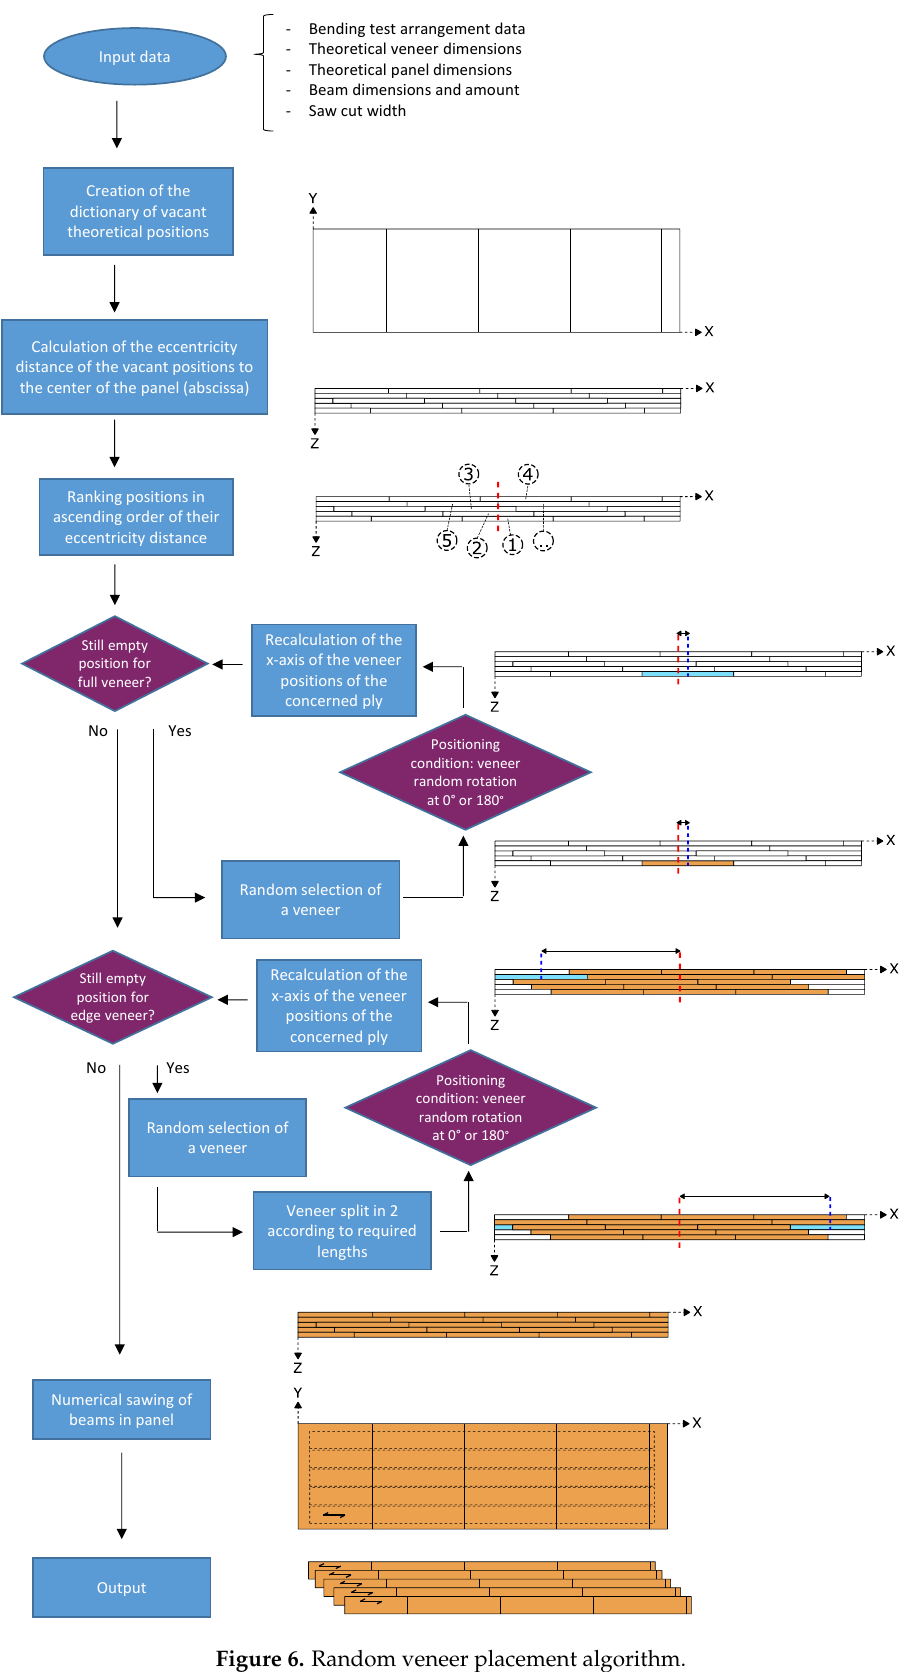
Figure 6. Random veneer placement algorithm.